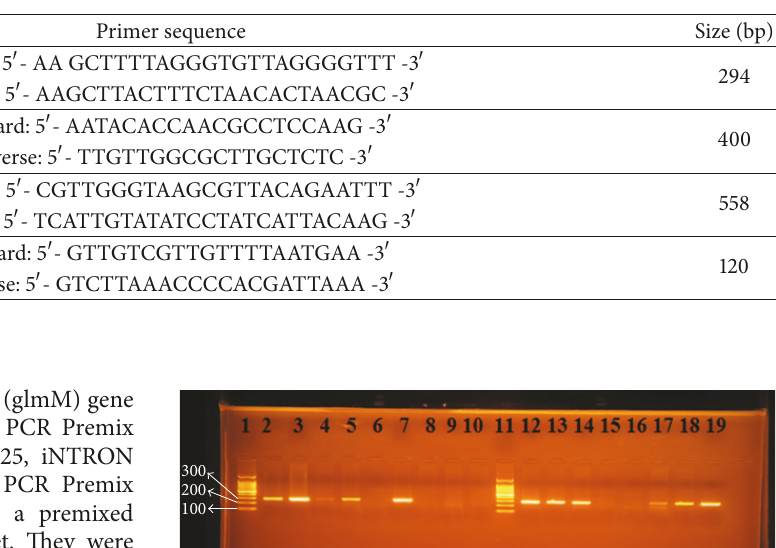
Table 1: Primer sequences used in this study.